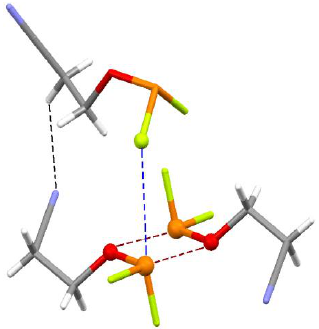
Figure 10. Fragment of crystal structure of 5,5-difluoro-4-oxa-5-phosphapentanenitrile, 14 . Colors: red = oxygen, orange = phosphorus, blue = nitrogen, green = fluorine, white = hydrogen, gray = carbon. Dashed lines show P---F and P---O σ-hole interactions and C–H---N hydrogen